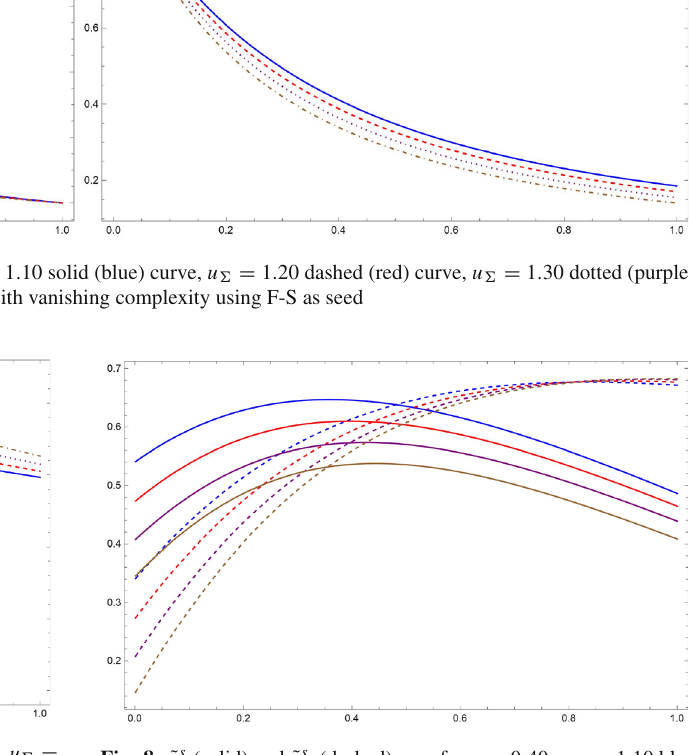
Fig. 8 ˜ v s r (solid) and ˜ v s ⊥ (dashed) vs x for y = 0 . 40 , u (cid:5) = 1 . 10 blue curve, u (cid:5) = 1 . 20 red curve, u (cid:5) = 1 . 30 purple curve and u (cid:5) = 1 . 40 brown curve. Second case with vanishing complexity using F-S as seed